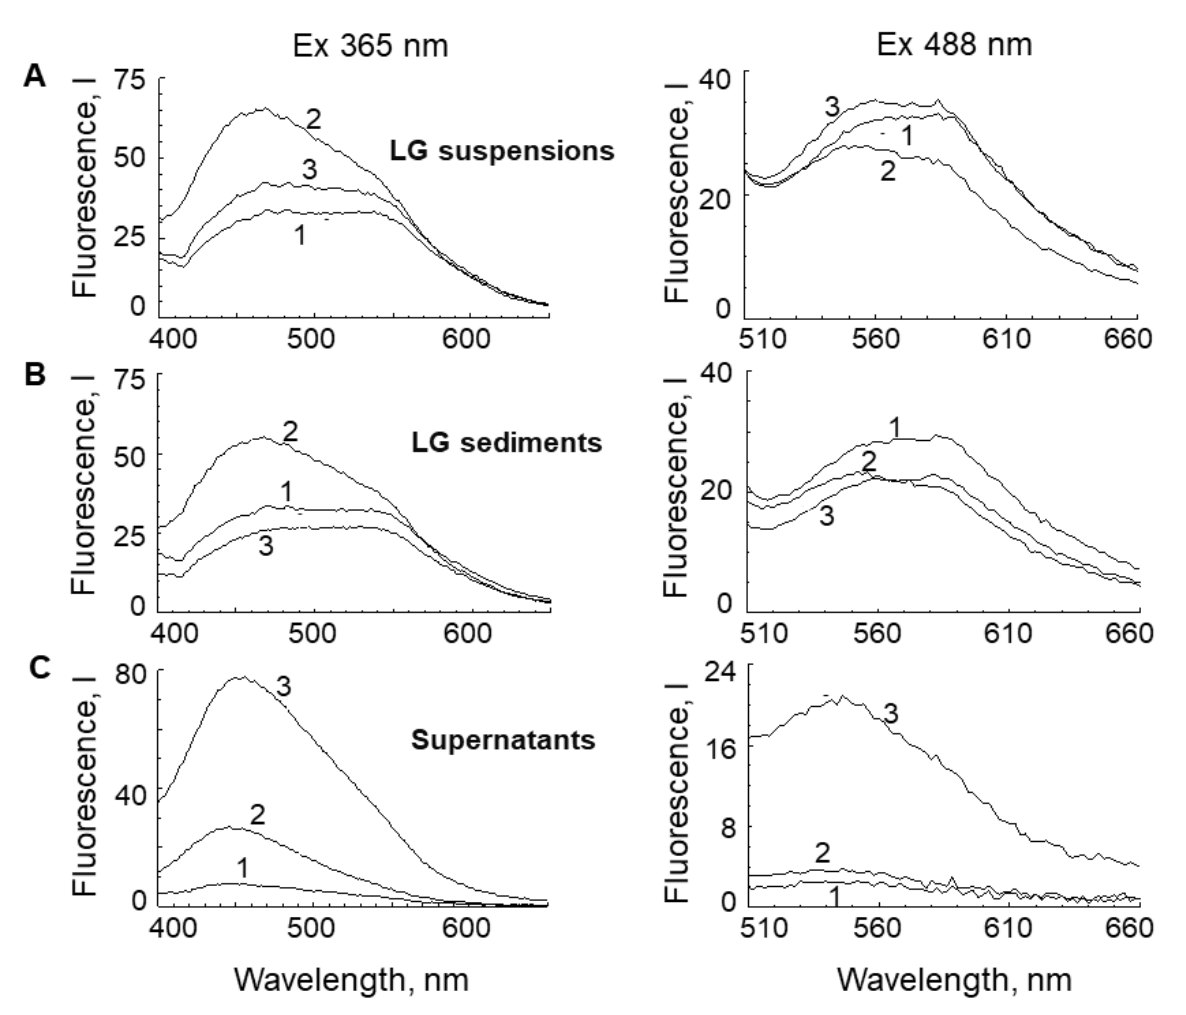
Figure 1. Fluorescence spectra of lipofuscin granule (LG) suspensions ( A ), LG sediments ( B ), and supernatants ( C ). 1 — control: LG suspension before light irradiation or incubation with superoxide radicals; sediment and supernatant obtained from this suspension. 2 — LG suspension after 60 min visible light irradiation; sediment and supernatant obtained from this suspension. 3 — LG suspension after 60 min incubation with potassium superoxide; sediment and supernatant obtained from this suspension. The wavelengths of fluorescence excitation were 365 nm (left) and 488 nm (right). Importantly, in the supernatant obtained from the original LG suspension, the fluo- rescence intensity was very low, indicating a low content of hydrophilic oxidized forms